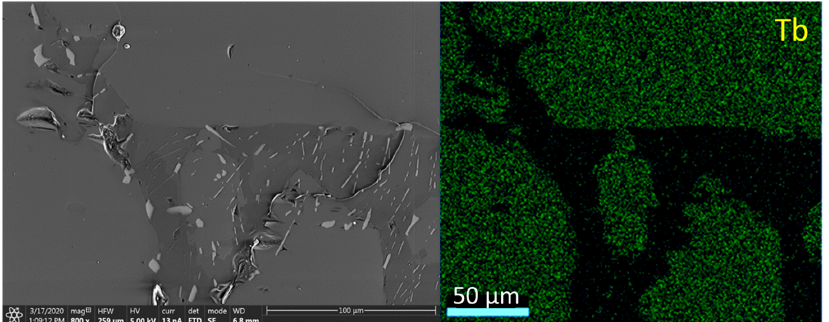
Figure 15. Sample presentation of the energy-dispersive spectroscopy analysis of the area from sample No. 2 of LMP doped with 0.8-mol% Tb, with mapping of the Tb distribution (right-hand panel). In contrast to LMPs doped with Tb, those doped with Tm (irrespective of the concen- tration) showed Tm presence in the whole investigated microregion, although there were visible areas with a larger amount of Tm (Figures 16 and 17).